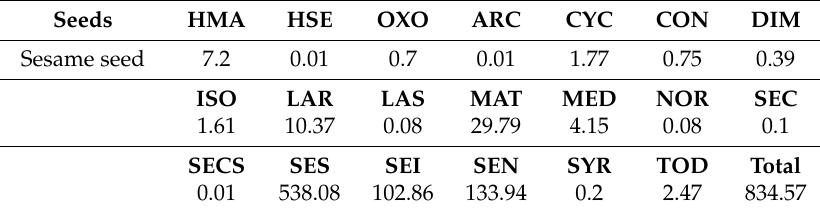
Table 1. Lignan content of sesame seed (mg/100g food). Data collected from phenol explorer [18].